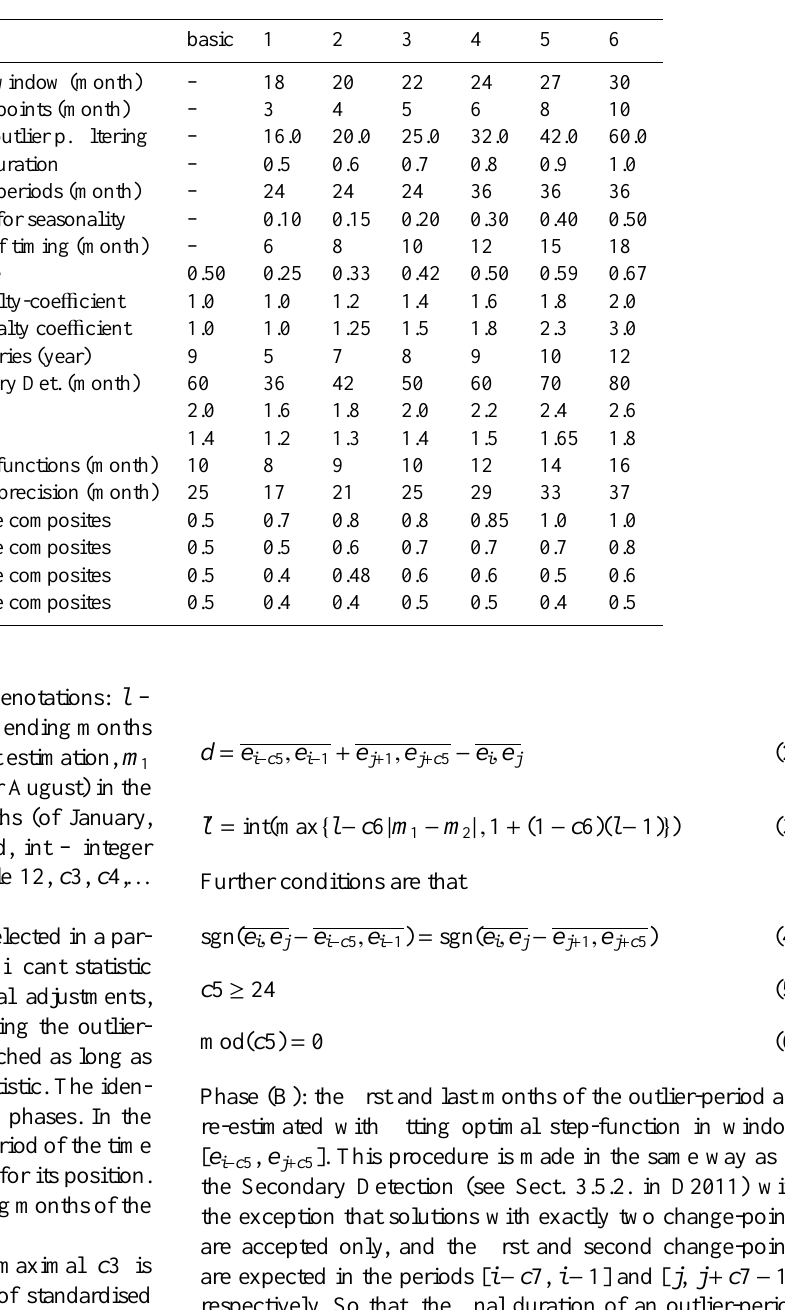
Table 1. Moving parameters and their values in the experiments. Six values are allowed for each parameter. In column “basic” the values in ACMANTv1 (D2011) are